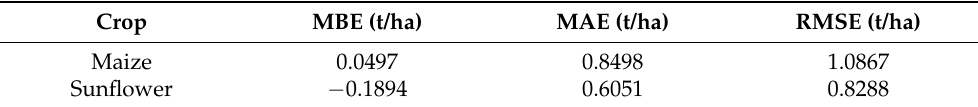
Table 3. Validation scores given with standard statistical metrics. Crop MBE (t/ha)